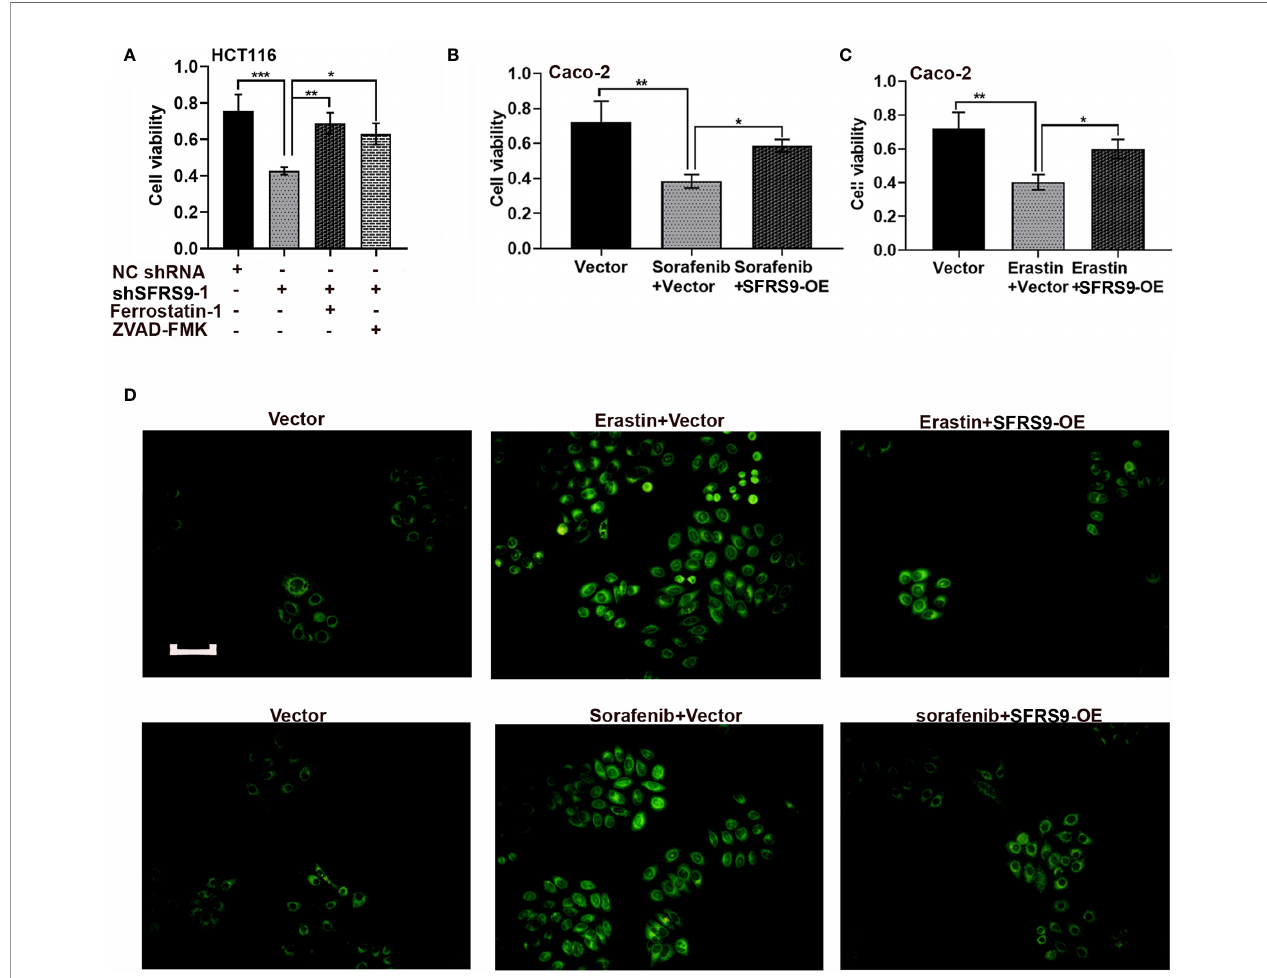
FIGURE 5 | Effects of SFRS9 on ferroptosis in CRC cells. (A) The viability of HCT116 cells treated with SFRS9 shRNA with or without the indicated inhibitors was measured using the CCK-8 assay. (B) The viability of Caco-2 cells treated with SFRS9-OE vector with or without ferroptosis inducer sorafenib was measured using the CCK-8 assay. (C) The viability of Caco-2 cells treated with SFRS9 OE vector with or without ferroptosis inducer erastin was measured using the CCK-8 assay. (D) C11-BODIPY staining of Caco-2 cells following transfection with SFRS9-OE vector with or without ferroptosis inducer erastin or sorafenib. Scale bars: 100 m m. Values are mean ± SD. *p < 0.05, **p < 0.01, ***p <